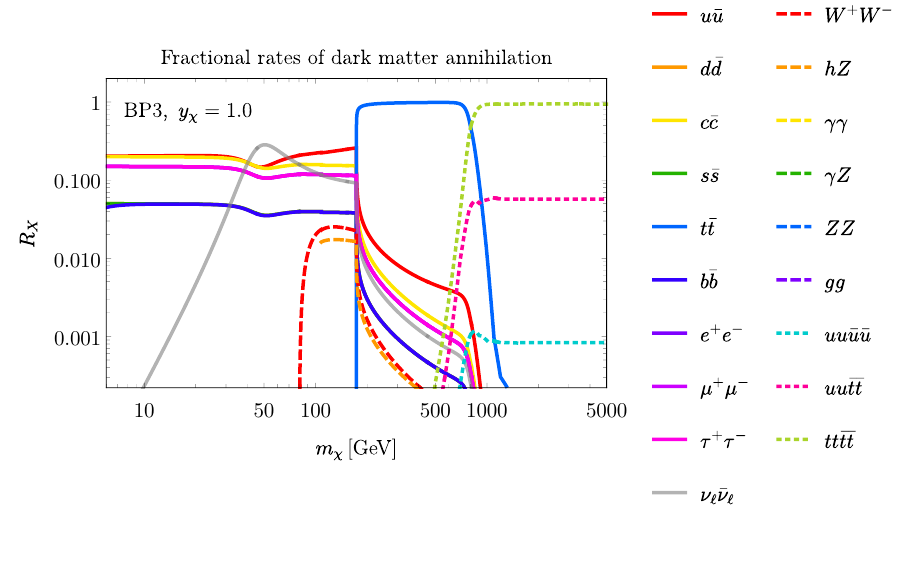
Figure 14 . Fraction R X of total dark matter annihilation rate as a function of m χ ≤ m ψ , for nineteen SM final states, in benchmark BP3 ( m ϕ = 1.15 TeV, m ψ = 5.0 TeV, λ 11 = 0.125 , and λ 33 = 0.75 ). Annihilation fractions are not meaningfully different in BP1 and BP2.